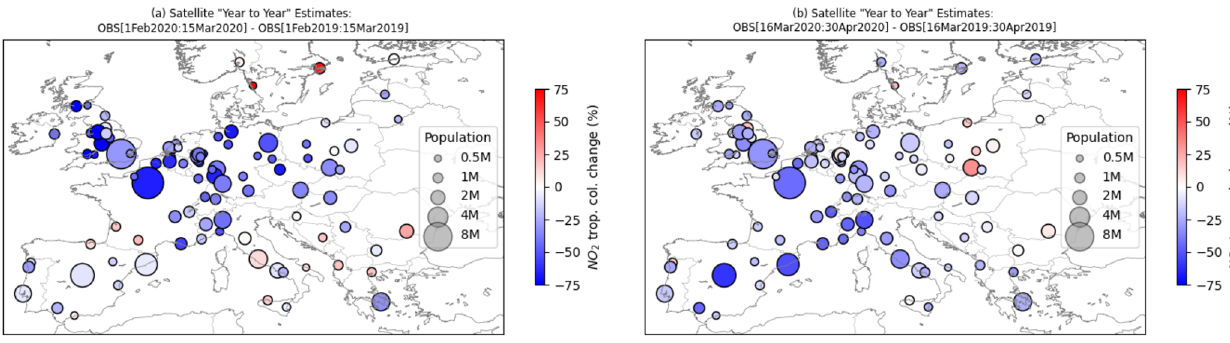
Figure 4. Year-to-year estimates of TROPOMI tropospheric NO 2 column change (%) for urban areas above 0.5 million inhabitants in 2019 (a) and 2020 (b) . The diameter of the circles is proportional to the population count in each urban